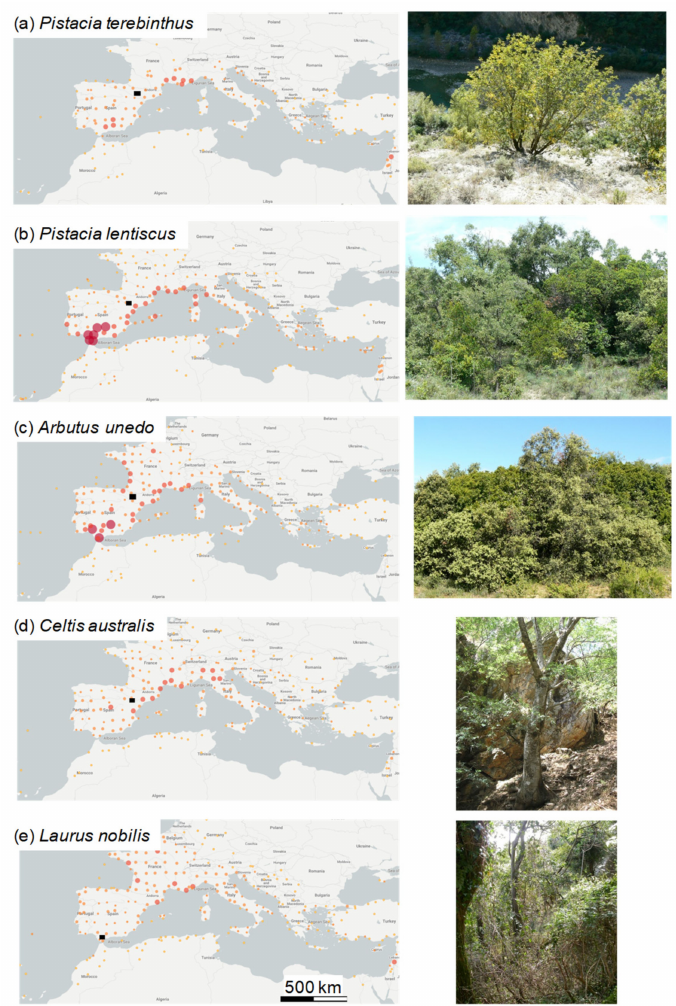
Figure 1. Maps show the distribution of the five study species in the Mediterranean Basin. Pictures show the studied tree species or sites where they were sampled. In the maps, the black squares indicate the approximate location of the study sites. Maps are based on occurrence data of the Global Biodiversity Information Facility database available from: https: // www.gbif.org (accessed on 5 October 2020). ◦ ◦ (cid:48) The P. terebinthus site (0 13’ E, 42 19 N, 474 m) is located on a steep slope on rocky deposits, near the Cinca river. Soils are basic. The vegetation is a Mediterranean scrubland with scattered trees of oak species ( Quercus ilex L. subsp. ballota , Quercus faginea Lam.) and shrub species ( Viburnum tinus